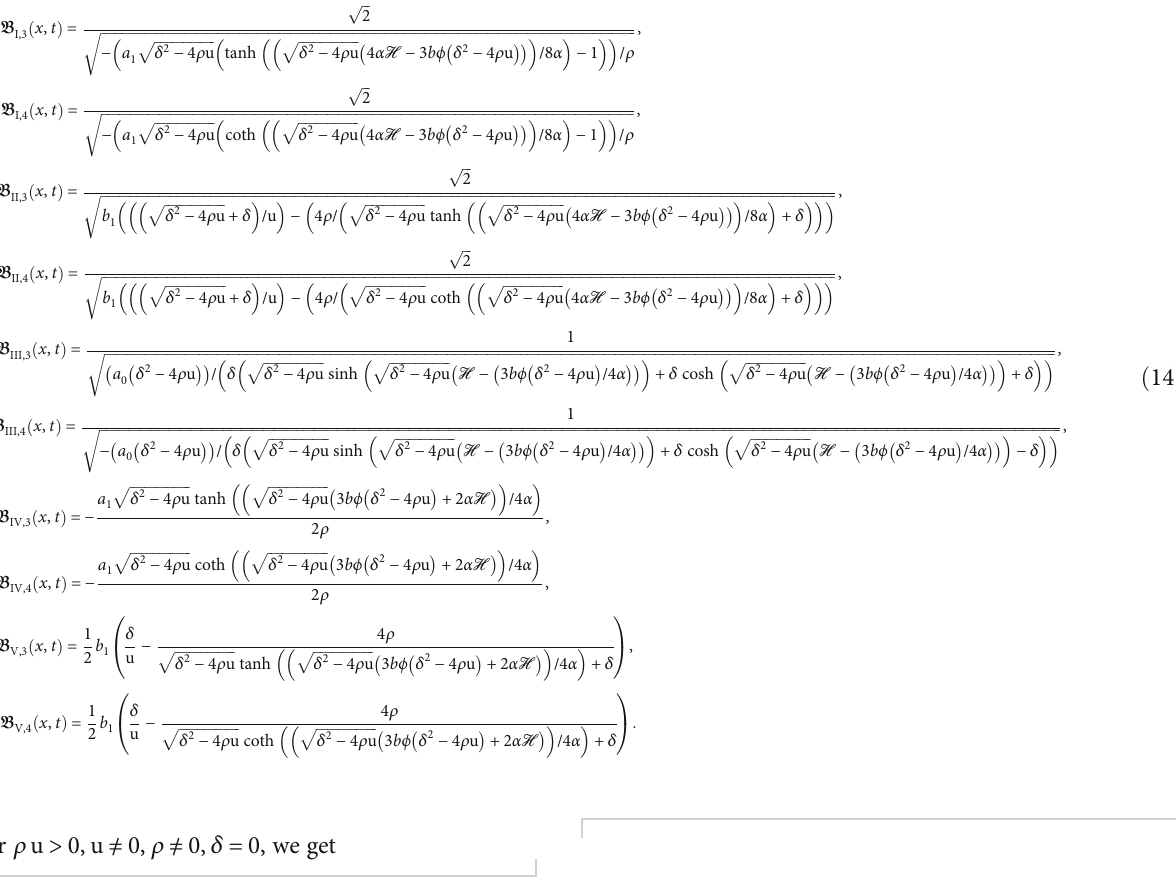
p ffiffiffiffiffiffiffiffiffiffiffiffiffiffiffiffiffi ffiffiffiffiffiffiffiffiffiffiffiffiffiffiffiffiffi δ 2 − 4 ρ u − a 1